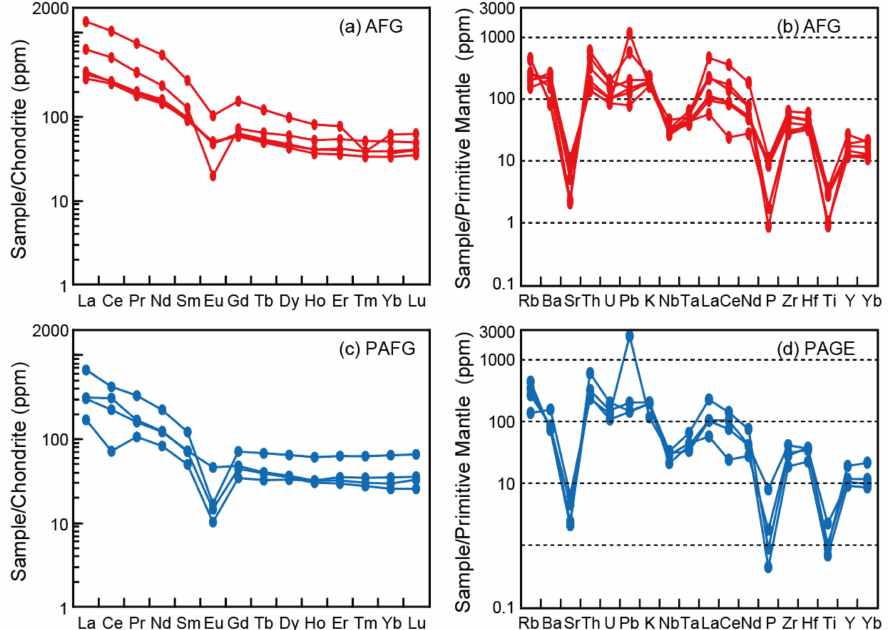
Figure 10. Chondrite-normalized rare earth elements and primitive mantle-normalized multi- elements diagrams for AFG ( a , b ) and PAFG ( c , d ). The chondrite and primitive mantle values are from [45]. The symbols are the same as those in Figure